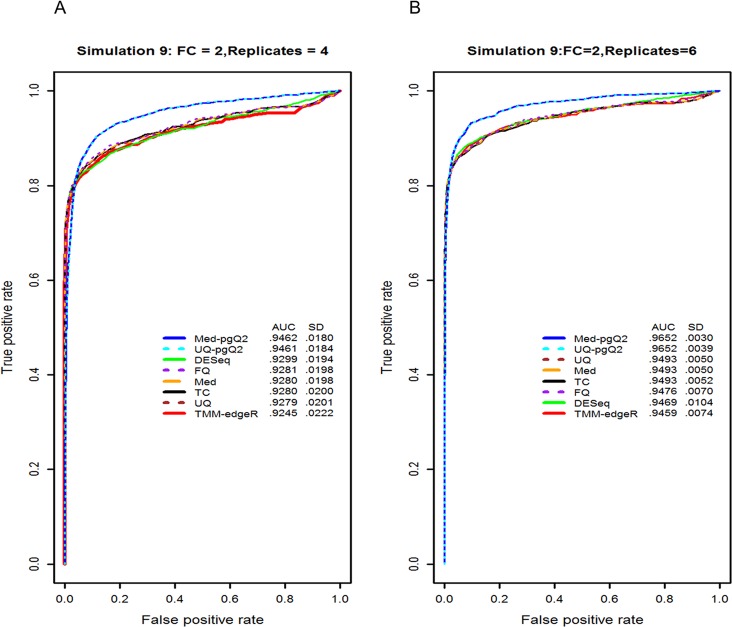
ROC curve and AUC values from the simulated data with 4 and 6 replicates in each condition.Illustrated are the ROC curves and AUC values (inset) in analyzing the impact of biological replicates on the performance of normalization methods. We used the simulated data with four biological replicates (A) and six biological replicates (B), which contain 1,500 DEGs with 2 FC difference between two conditions. Our methods (UQ-pgQ2 and Med-pgQ2) are in cyan and blue, respectively.